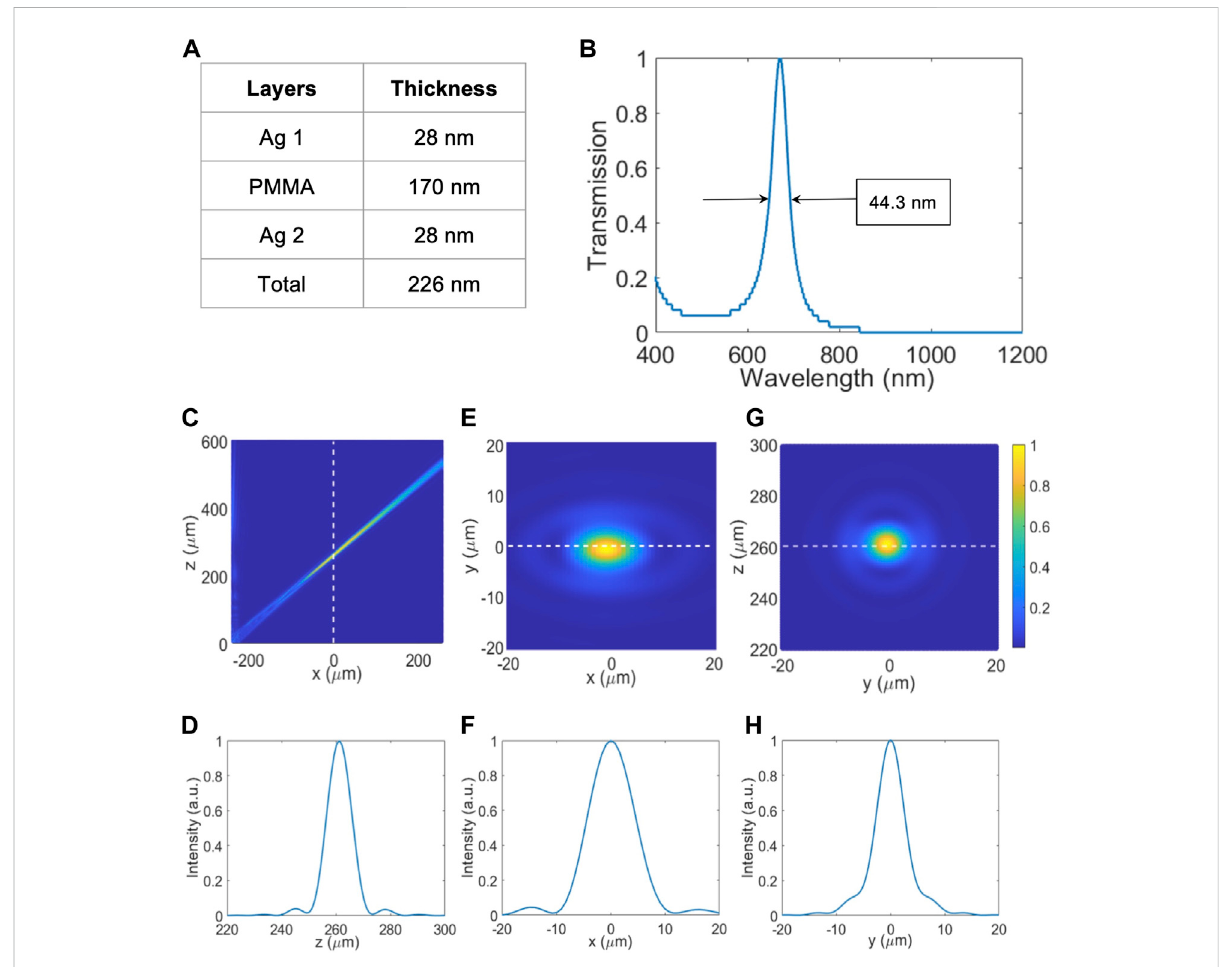
FIGURE 4 Simulation results for 671 nm NBPF and off-axis metalens. (A) Table consolidating the thickness of each NBPF layer and its material. (B) Transmission vs. Wavelength plot of 671 nm NBPF for the range of 400 – 1200 nm with peak wavelength = 670.6 nm and FWHM = 44.3 nm. (C) Normalizedintensity plotofthefocalpointpro fi leof671 nmoff-axis focusing onthex-zplane. (D) Normalized intensity plotofthefocalpoint along the z-axis. (E) Normalized Intensity plot of focal point pro fi le of 671 nm off-axis focusing on the x-y plane. (F) Normalized intensity plot of the focalpoint alongthex-axis. (G) Normalized Intensityplotoffocal pointpro fi leof671 nmoff-axisfocusing onthey-zplane. (H) Normalized intensity plot of the focal point along the